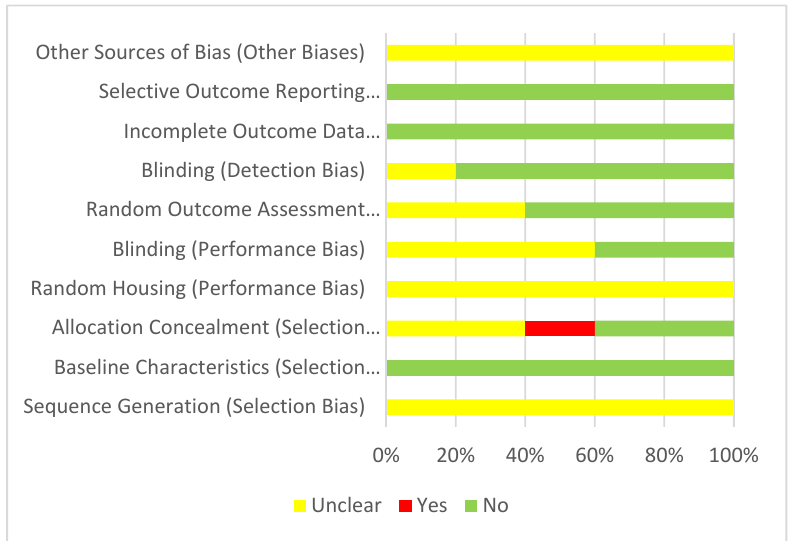
Figure 3. Risk of bias assessment for cerebral ischemia-reperfusion injury.